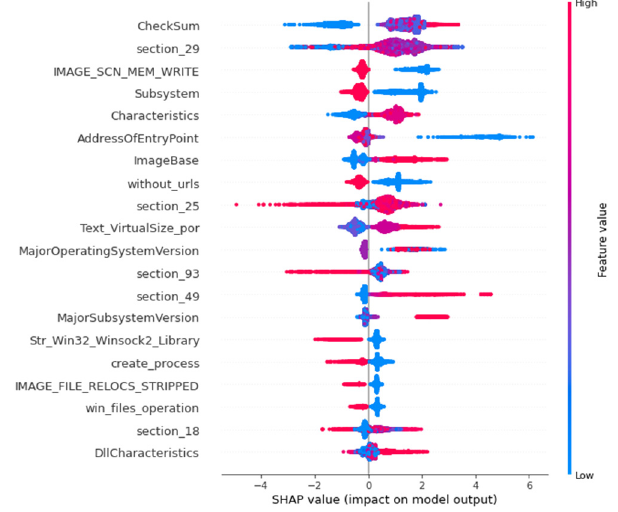
Figure 3. Summary plot designed to display an information-dense summary of how the top features in a dataset impact the model’s output.